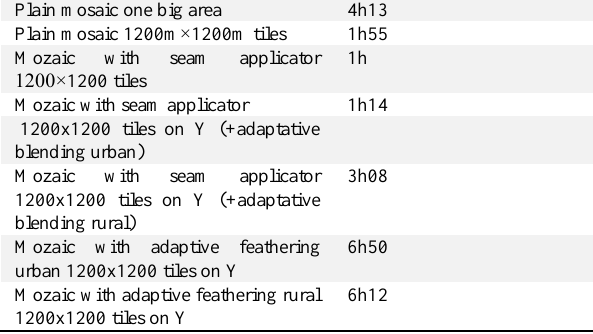
Table 5. Processing time with 1000 images for the